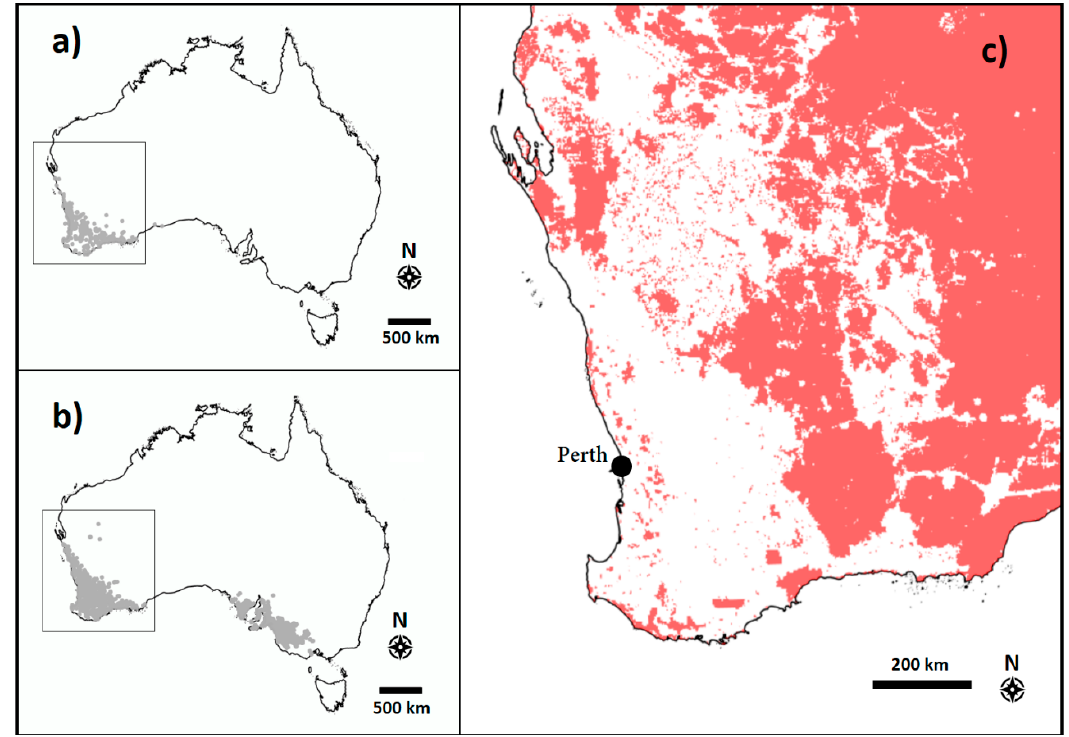
Figure 6. Distribution maps for Amphipogon turbinatus ( a ) and Neurachne alopecuroidea ( b ), and the extent of unaltered native vegetation in southwest Western Australia ( c ). The boxes in panels a and b indicate the area enlarged in panel c . Maps generated from Atlas of Living Australia using species occurrence records data ( a and b ) and selecting “remaining vegetation” within the “Vegetation–Condition” layer ( c ) [32–34].